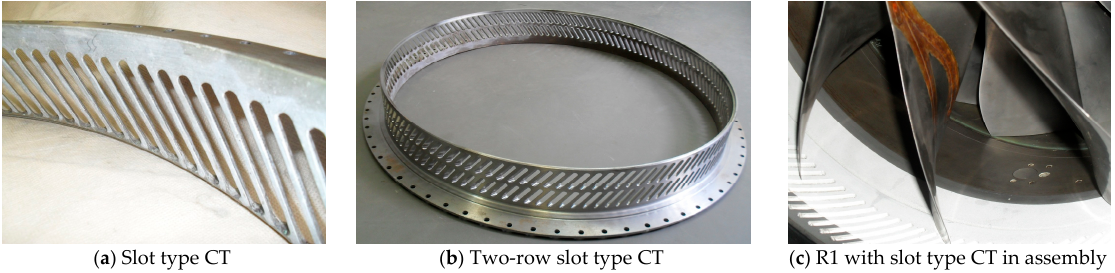
Figure 29. Slot type casing treatments. ( a ) Slot type CT; ( b ) two-row slot type CT; ( c ) R1 with slot type CT in assembly.